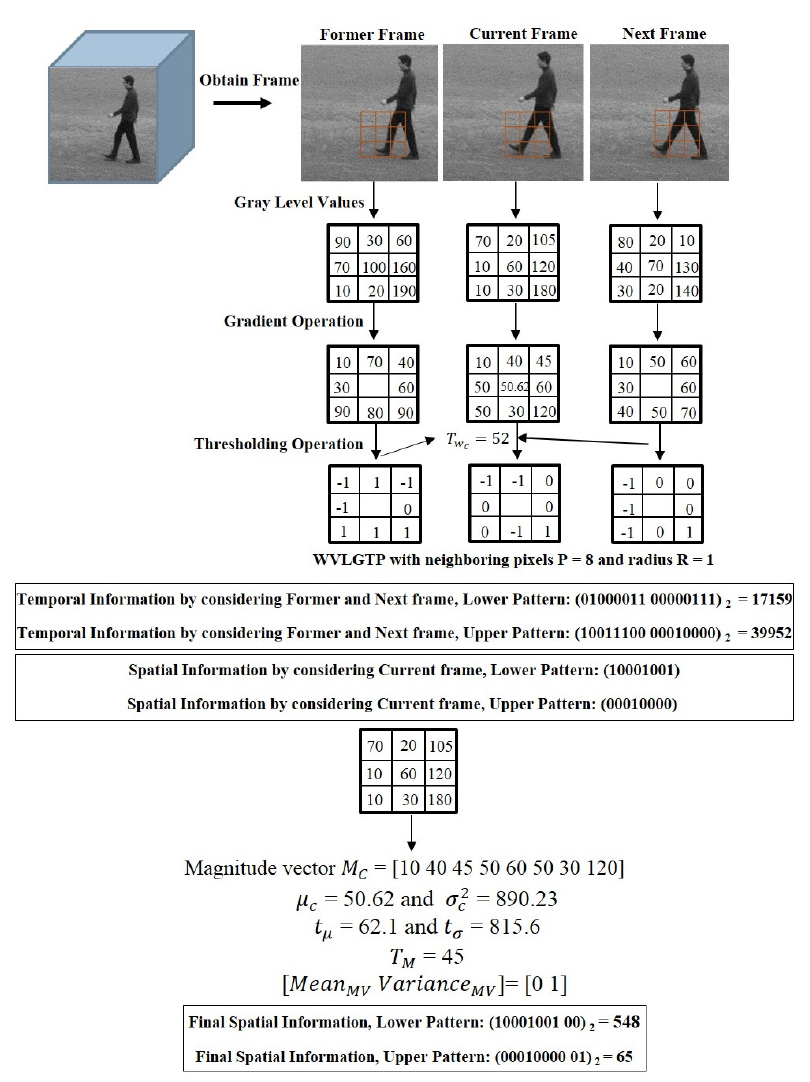
Figure 4. The feature extraction process of Weber’s law based Volume Local Gradient Ternary Pattern